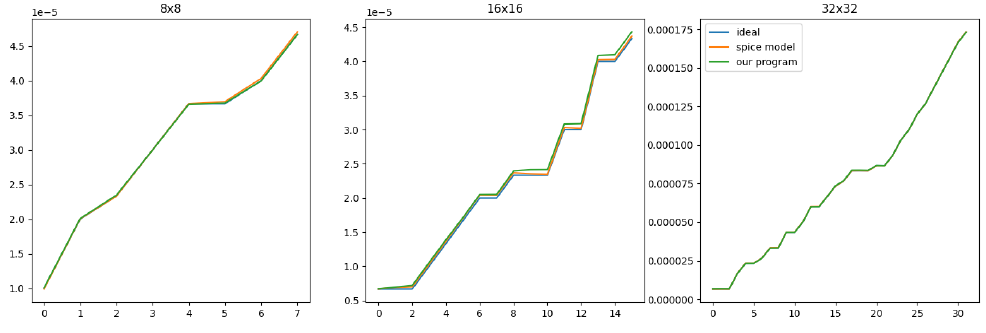
Figure 11. Accumulated result of ReRAM array.